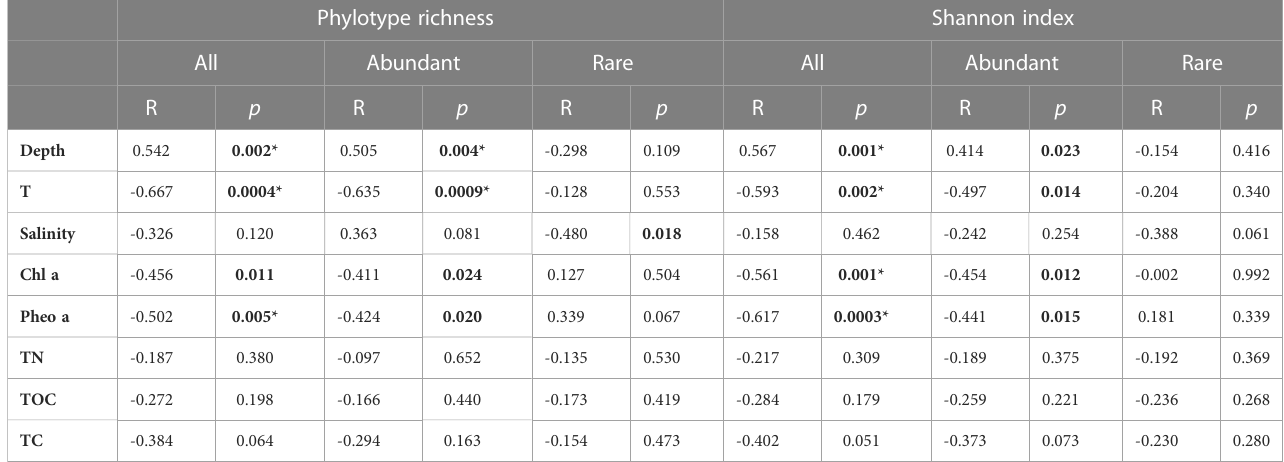
TABLE 1 Pearson correlations between two a -diversity indices (phylotype richness and Shannon index) and eight environmental